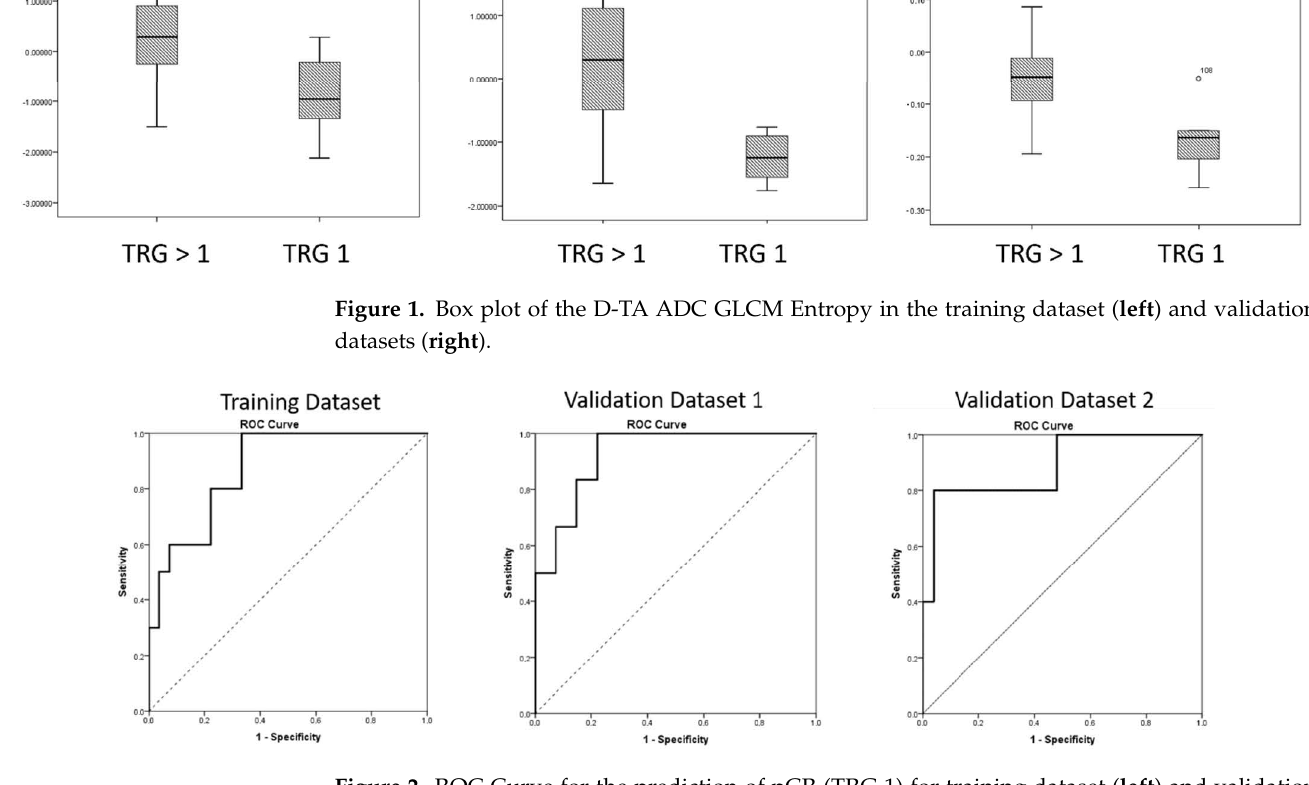
Table 4. Specificity, sensibility, and accuracy of the cut-off of the texture parameter GLCM. Entro- py ADC.